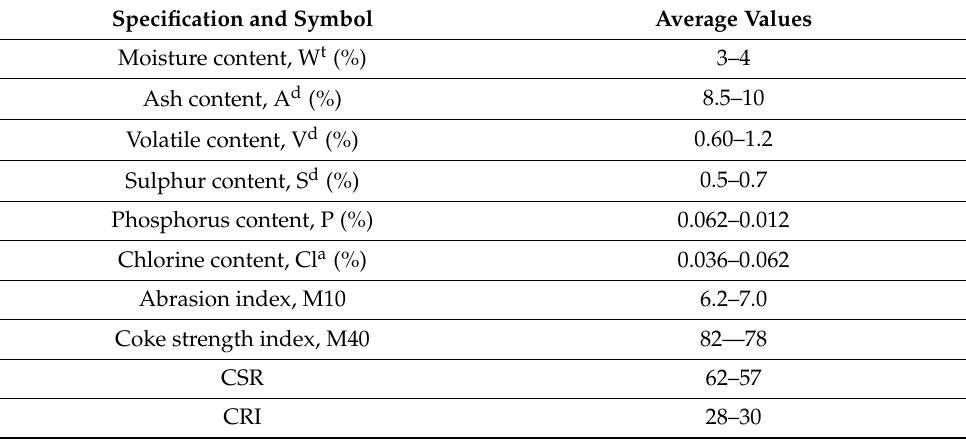
Table 5. Average values of the physical and chemical specifications of cokes